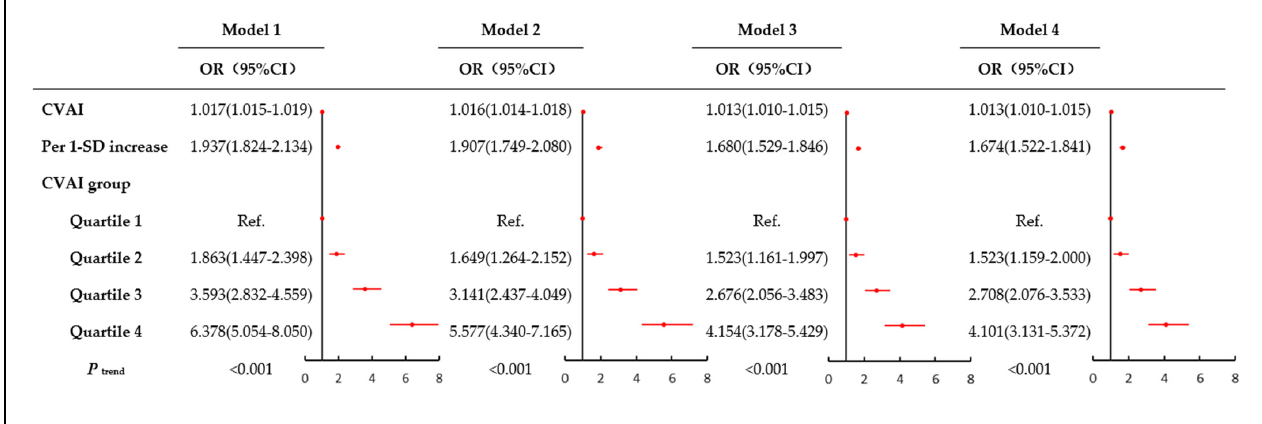
Table 3. Subgroup analysis of different CVAI levels and risk of CAS prevalence. Subgroup